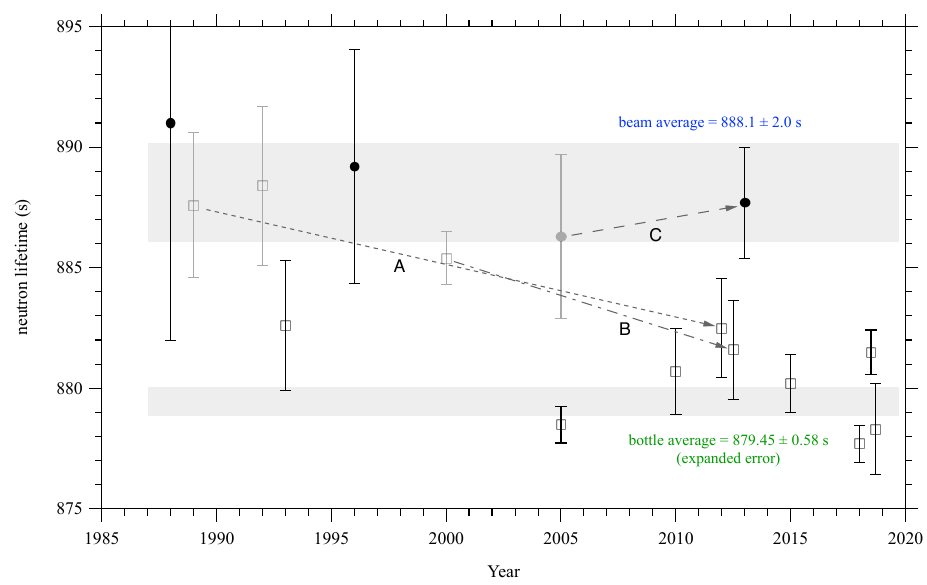
Figure 8. A summary of neutron lifetime experimental measurements since 1985. Details of individual measurements can be found in [23,25,26,35–37,39,40,43,44,46,48–50,60,61]. Solid circles are the beam method and open squares are the UCN storage method. Gray points are measurements withdrawn or superceded by later work (old and new indicated by arrows). The shaded bars are weighted averages ± 1 standard deviation of uncertainty. The UCN storage uncertainty is expanded (see